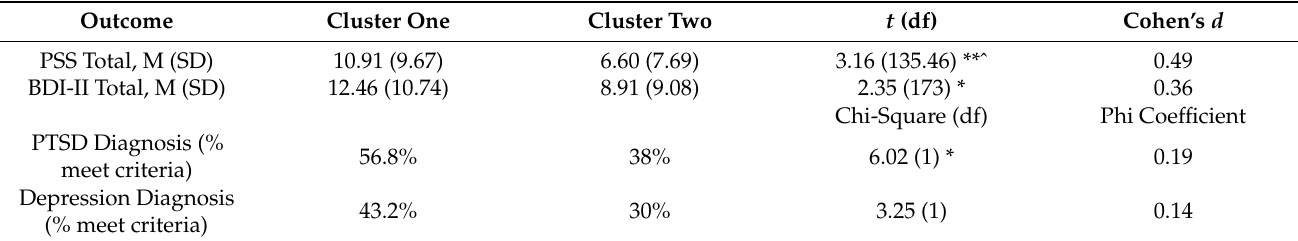
Table 3. PTSD and depression differences across